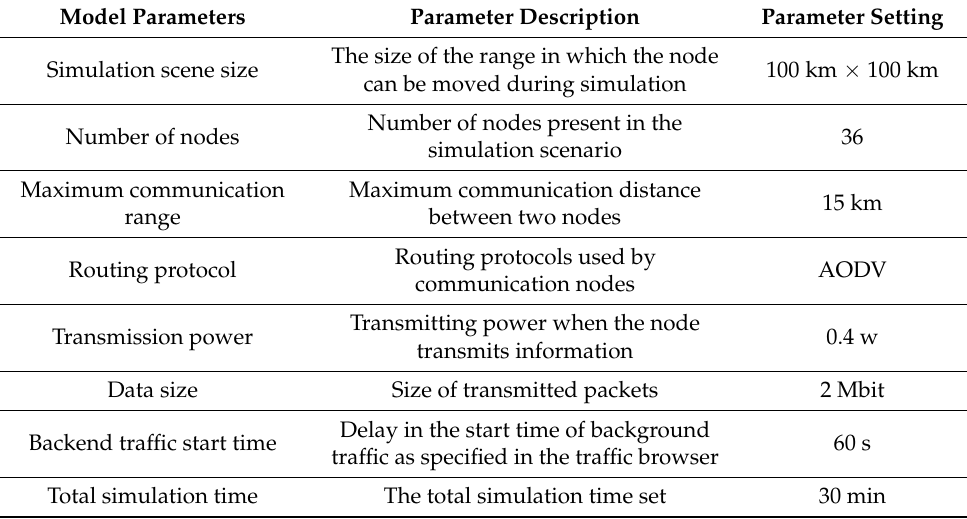
Table 1. Simulation parameter